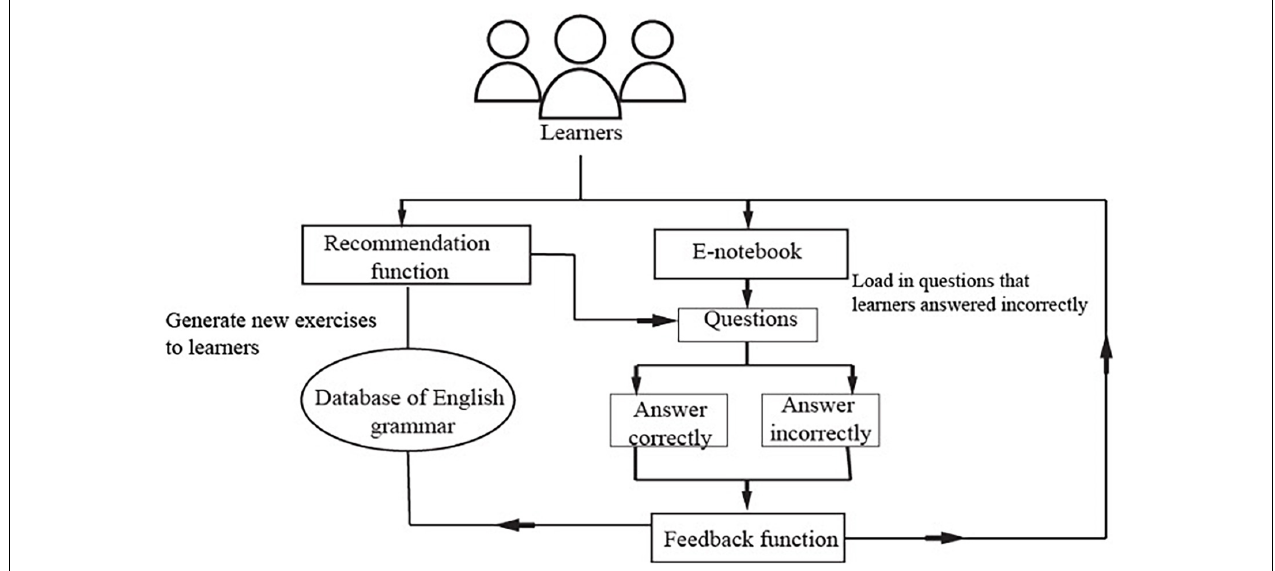
FIGURE 1 | The operating mechanism of the system. Modified from Chen et al. (2019) operating mechanism of a quiz